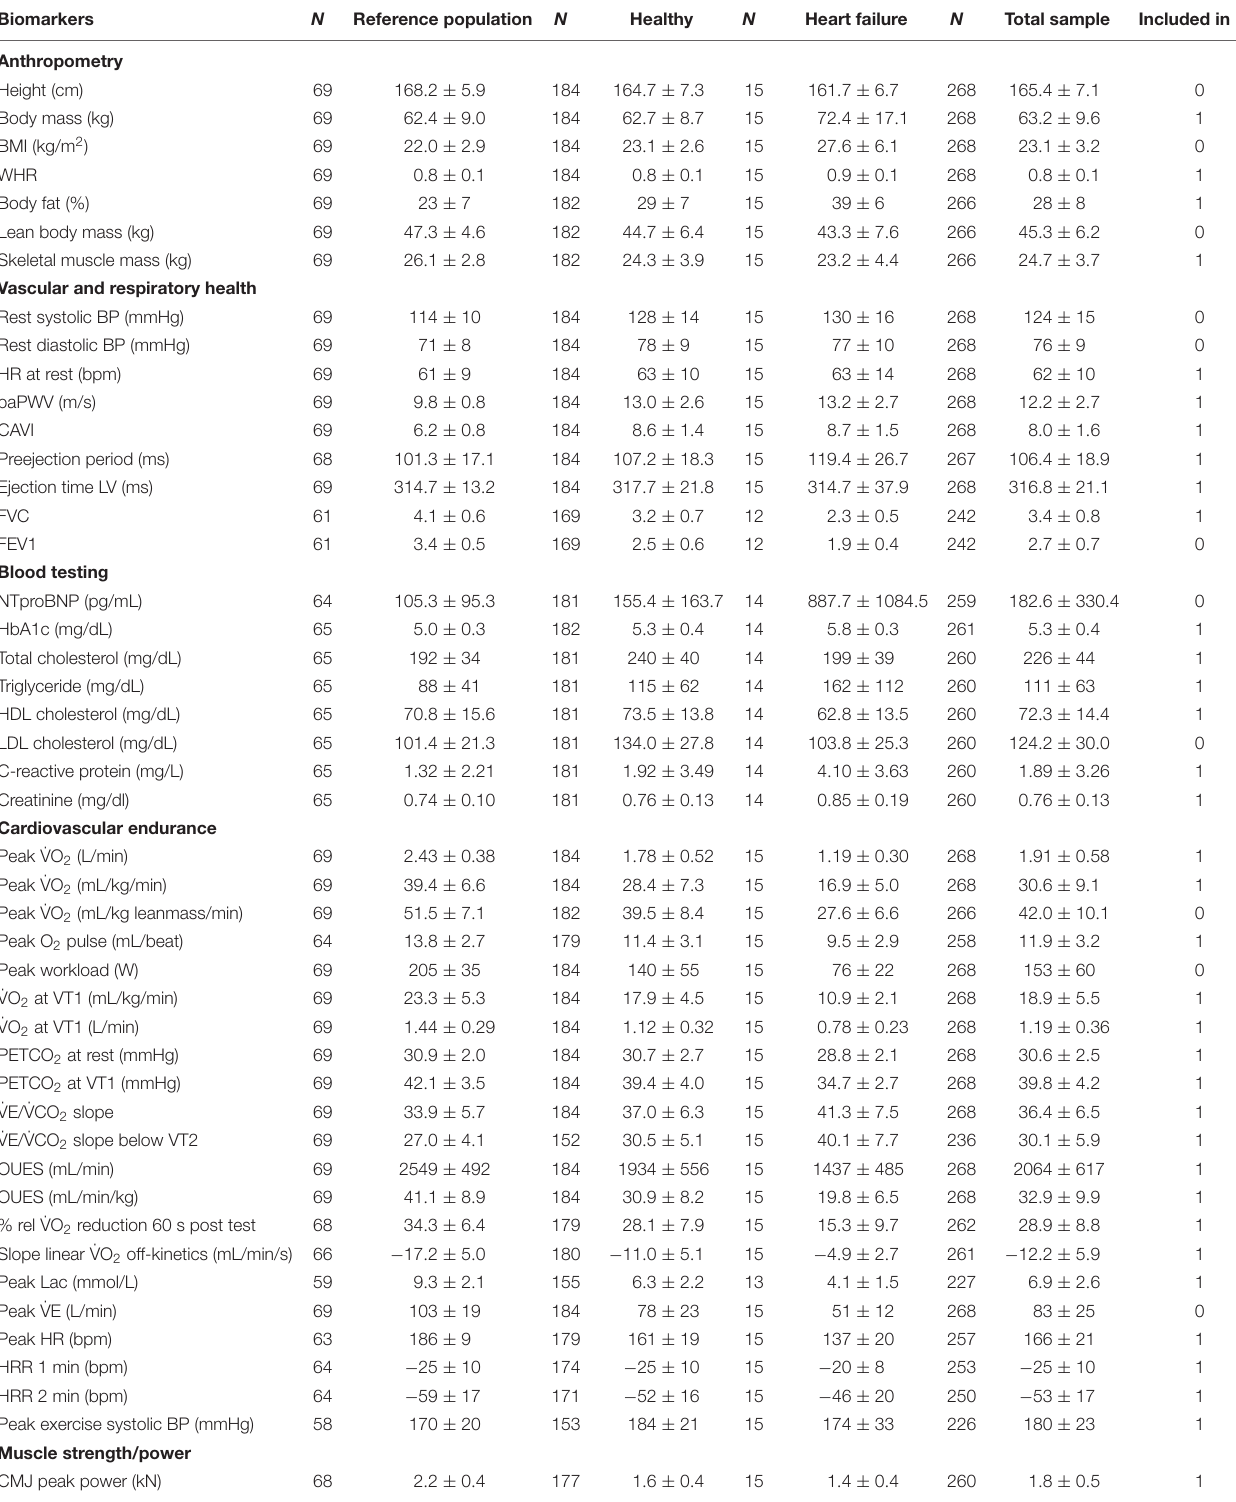
TABLE 3 | Descriptive characteristics of the female participants separated into Reference Population (healthy participants aged ≤ 39 years), Healthy (healthy participants aged ≥ 40 years), and Heart Failure (patients with heart failure). Data are presented as mean ± standard deviation if not stated otherwise. Biomarkers N Reference population N Healthy N Heart